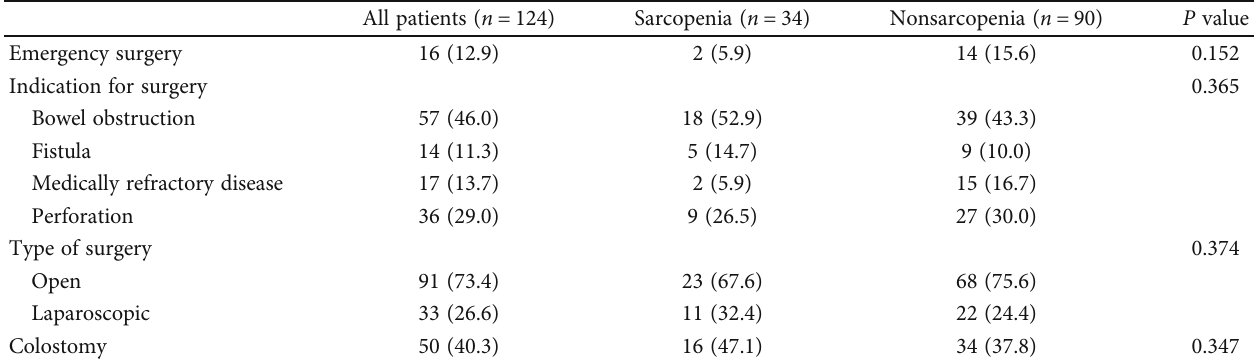
Table 2: Surgical details in CD patients with or without sarcopenia.